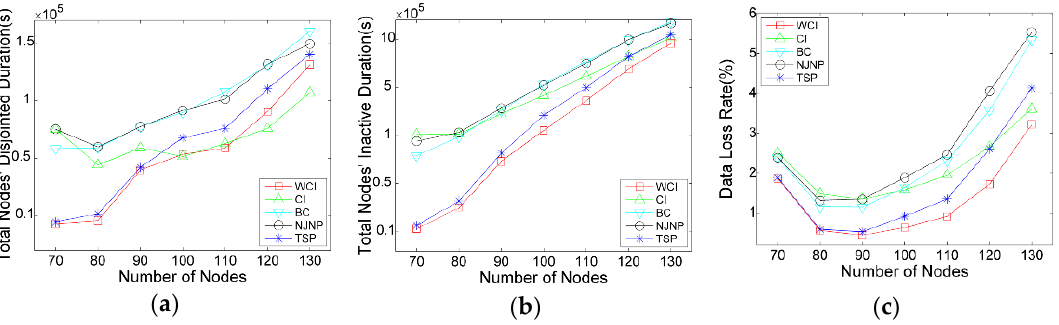
Figure 5. Impact of | N | on the charging scheduling algorithms: ( a ) Total nodes’ disjointed time; ( b ) Total nodes’ inactive time ; ( c ) Network’s data loss rate .